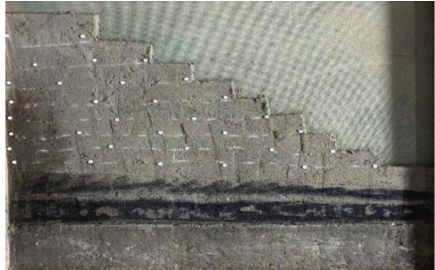
Figure 9: Initial